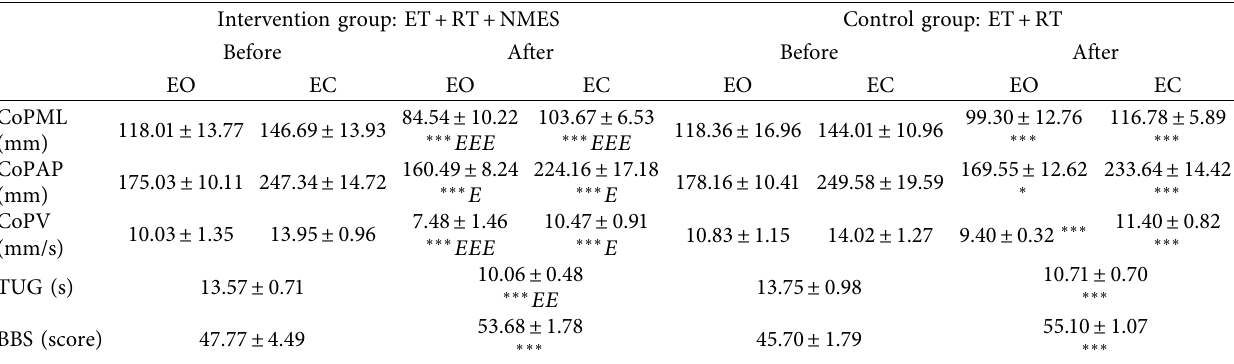
Table 5: Mean values and standard deviations of static and dynamic balance outcomes before and after the intervention. Intervention group: ET+ RT+NMES Control group: ET+RT Before After Before After